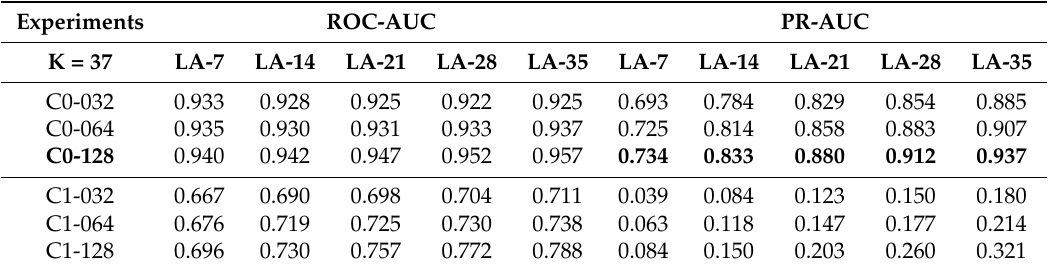
Table 8. ROC and PR K = 37 as test results of Two Clusters Kmeans in KNN with various timesteps.